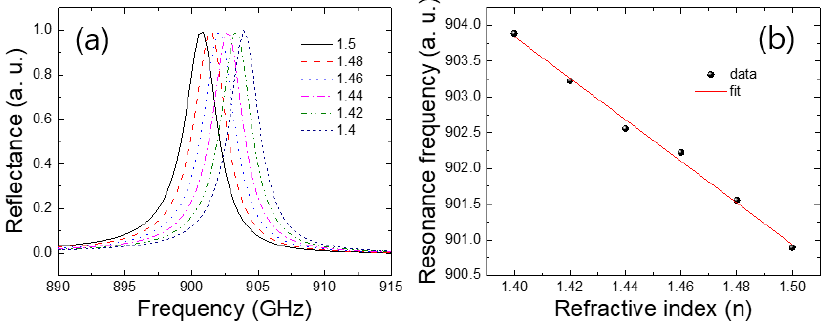
Figure 7. Dependence of the refractive index on the thickness of the sensing layer: ( a ) THz reflectance and ( b ) the resonance frequency.